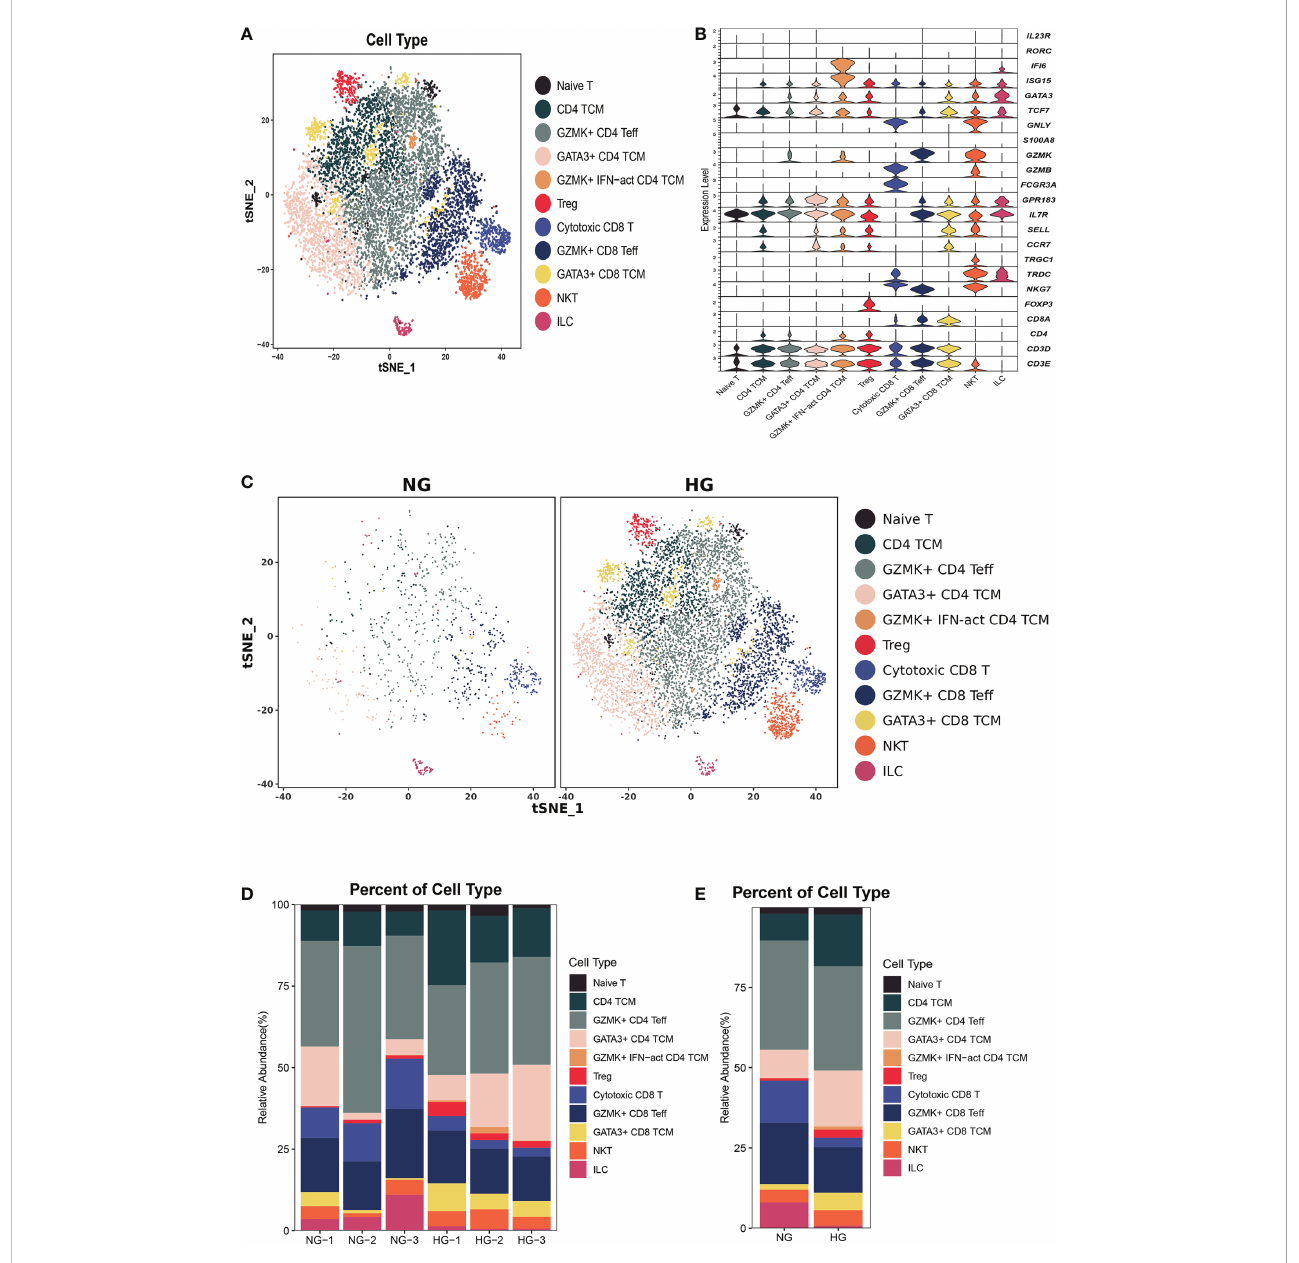
FIGURE 3 Clustering and classi fi cation of the T cell subclusters of deep fascia tissue. (A) tSNE visualization of T cell subclusters from deep fascia tissue. (B) Violin plots showing marker genes across T cell subclusters. (C) tSNE visualization of T cell subclusters from deep fascia tissue in HG and NG. (D) Bar plots showing the relative percentage of T cell subclusters for each sample. (E) Bar plots showing the relative percentage of T cell subclusters in HG and NG. HG, high stress group; NG, normal stress group; TCM, central memory T cell; Teff, effector T cell; Treg, regulator T cell; ILC=innate lymphoid cells; NKT=nature killer T